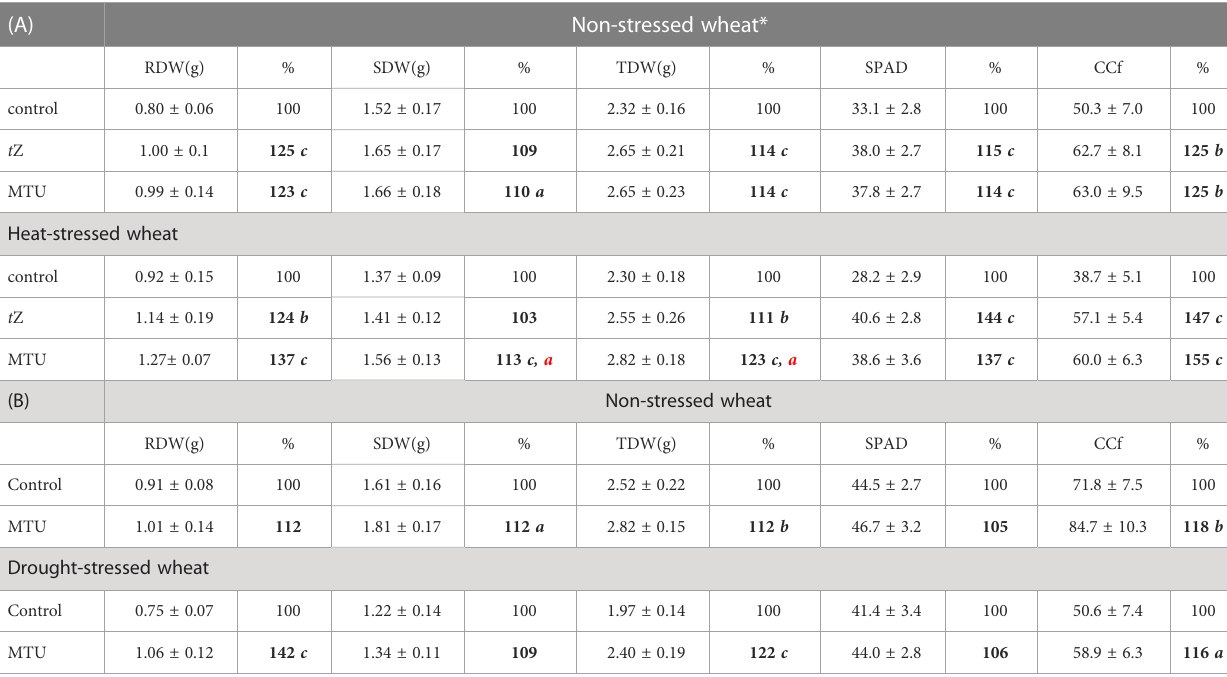
TABLE 1 Weight parameters and chlorophyll content in 45 or 48-days-old wheat plants.